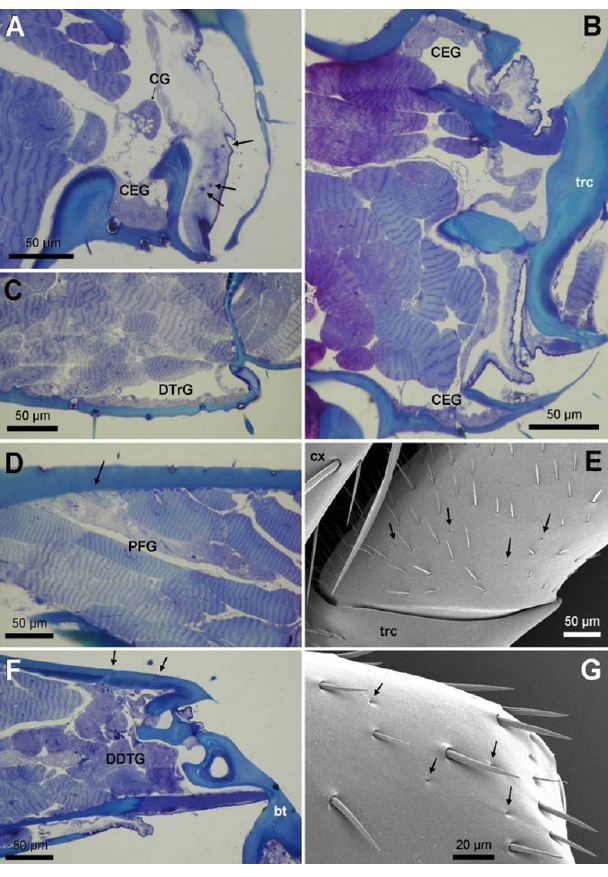
Fig 3 . A . Distal region of midleg coxa with coxal epithelial gland (CEG) and coxal gland (CG). Arrows indicate ducts of the coxal gland penetrating the articulation membrane with the trochanter. B . Mediodistal region of midleg coxa and articulation with trochanter (trc), showing belt-like coxal epithelial gland (CEG). C . Distal region of midleg trochanter with distal trochanter gland (DTrG). D . Prox- imal region of hindleg femur with proximal femoral gland (PFG), arrow shows duct penetrating cuticle. E . Scanning micrograph of proximal hindleg femur, arrows indicate opening of proximal femo- ral gland ducts. F . Distal region of midleg tibia and articulation with basitarsus (bt). Arrows indicate opening of ducts of the dorsodistal tibial gland (DDTG) through the cuticle. G . Scanning micrograph of distal part of foreleg tibia, arrows indicate duct openings of dorsodis- tal tibial gland. cx: